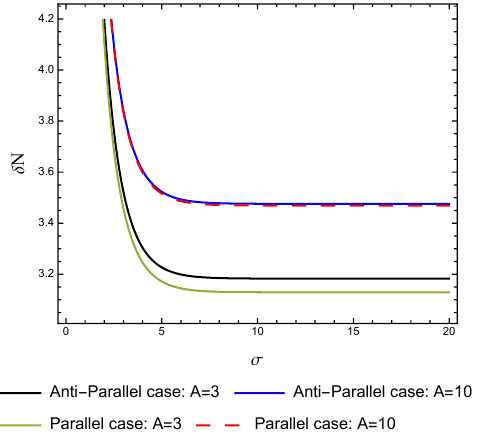
Figure 26 . Parallel and Anti-parallel motions in (1 + 3) dimensions with thermal background: δ N Vs σ plot with ∆ E = 1 , α = 0 . 2 . a B